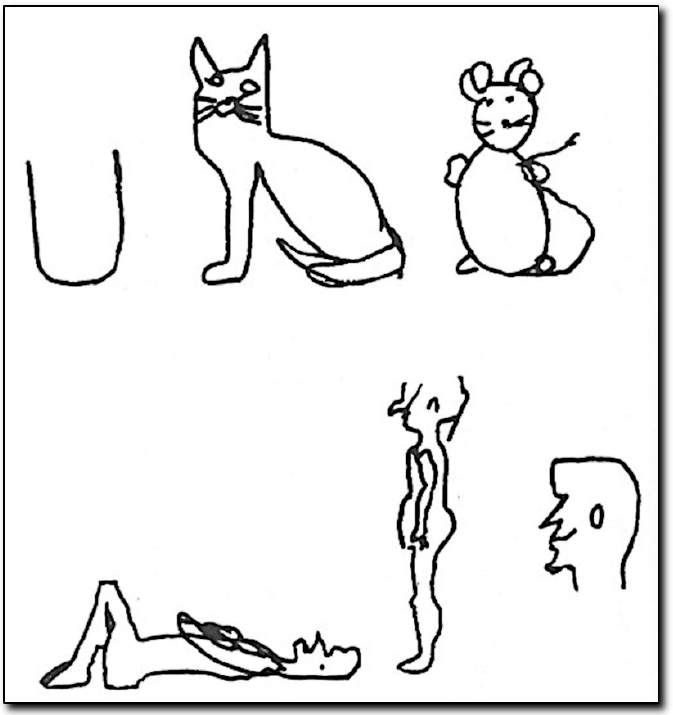
Figure 5. Drawings (a glass, a cat, a mouse, a man lying down and standing up, and a head) by Tracy as an adult, and blind since age two. (Kennedy 1993, Fig. 4.16, reproduced by permission of the